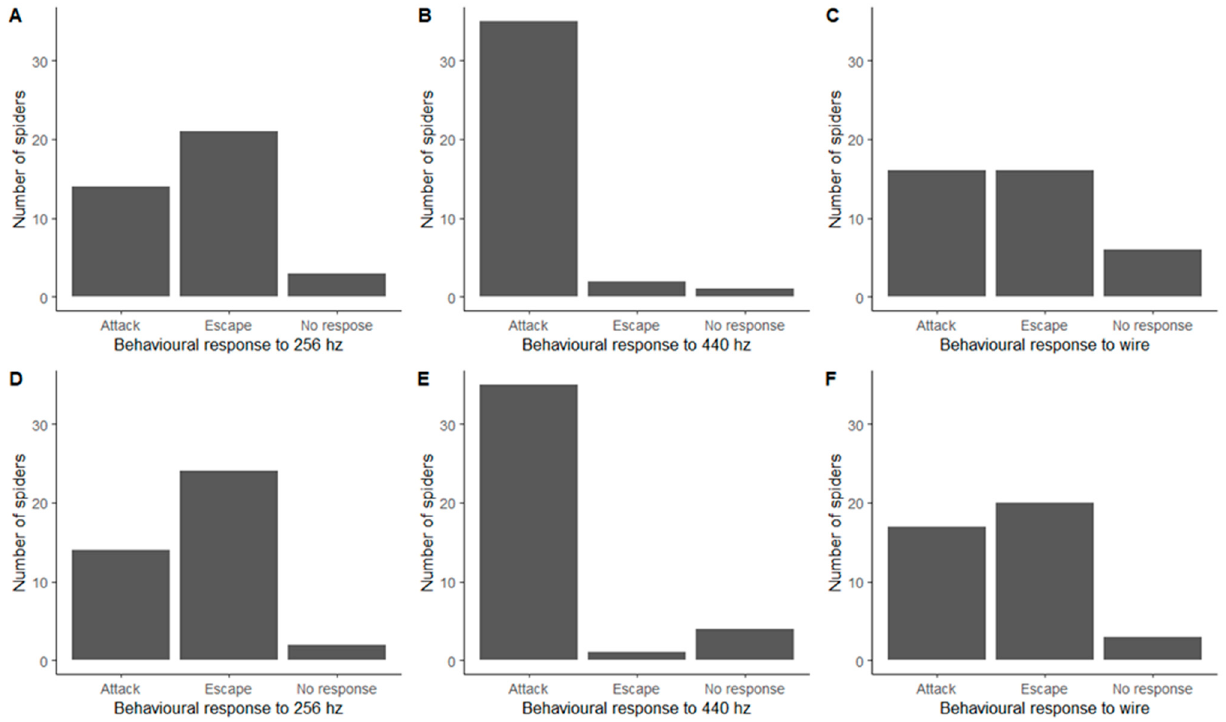
Figure 1. Behavioural responses of Metellina segmentata , showing the number of attack, escape, and no response behaviours seen for each stimulus. Split into 2020 method ( A – C ) and 2021 method ( D – F ).